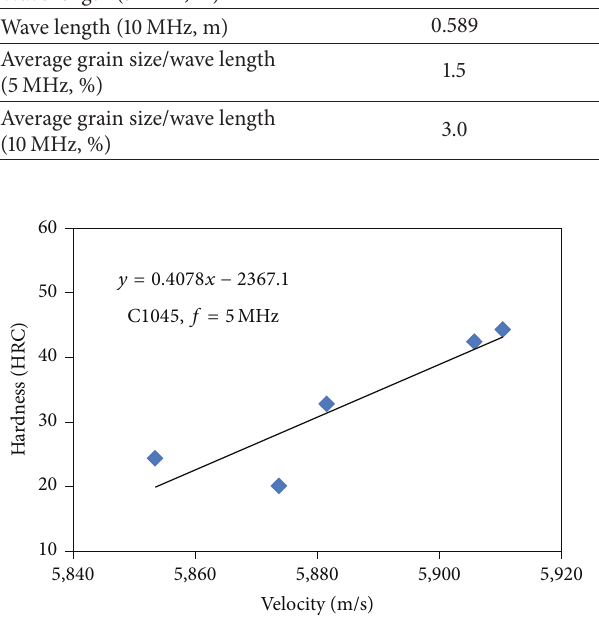
Figure 10: Relationship of velocity and hardness at different heat treatment temperatures using 5 MHz.